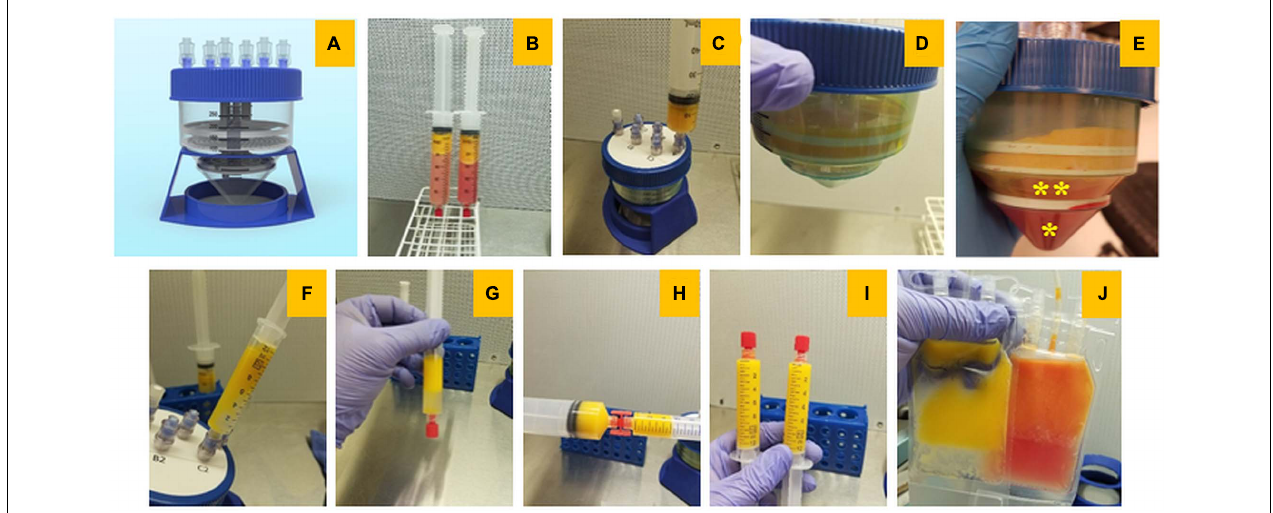
FIGURE 1 | Isolation of microfat from lipoaspirate using MiniTCTM device. (A) Image of the MiniTCTM microfat isolation device, (B) freshly collected lipoaspirate from adipose tissue, (C,D) injection of microfat through the Mini-TC port for centrifugation and processing, (E) post-centrifugation microfat clusters accumulate in the intermediate compartment of MiniTCTM (* – red blodd cells and debris, ** – desired fat fraction), (F) collection of processed microfat through the luer on top of the device, (G,H) separation of excess fluid and homogenization of microfat, (I) syringes of microfat ready to use, (J) cryopreservation of microfat